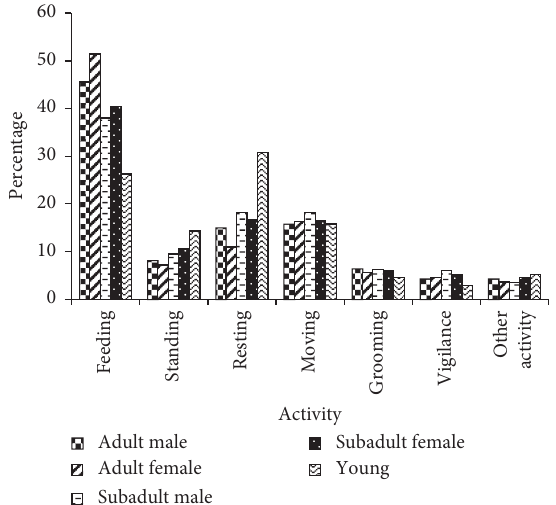
Figure 3: Percentage of different activities conducted across dif- ferent age and sex groups.